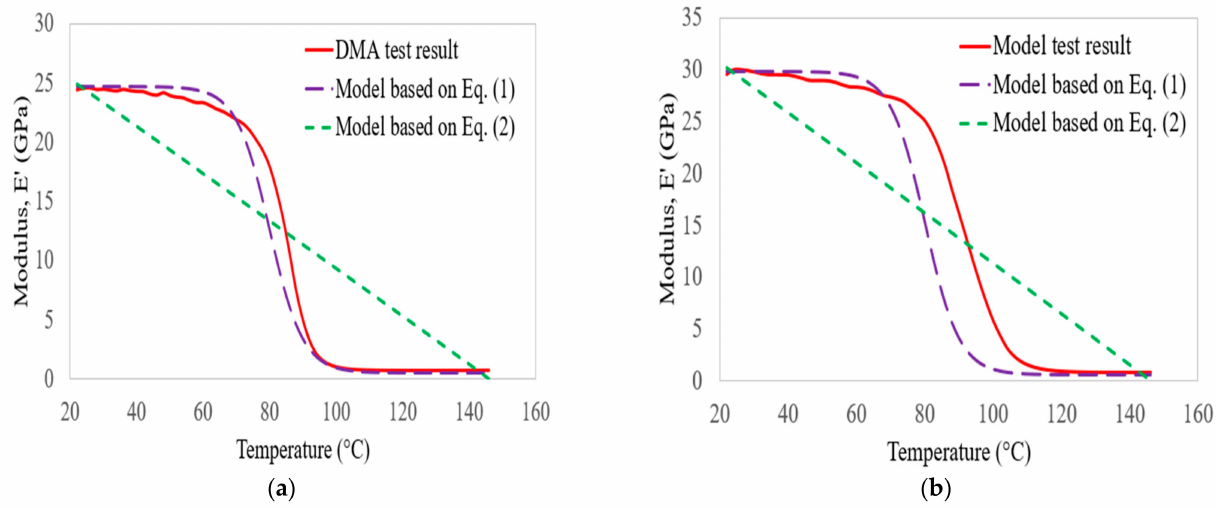
Figure 10. Comparison of glass laminate storage modulus results with empirical models at 1 Hz ( a ) and 100 Hz ( b ).